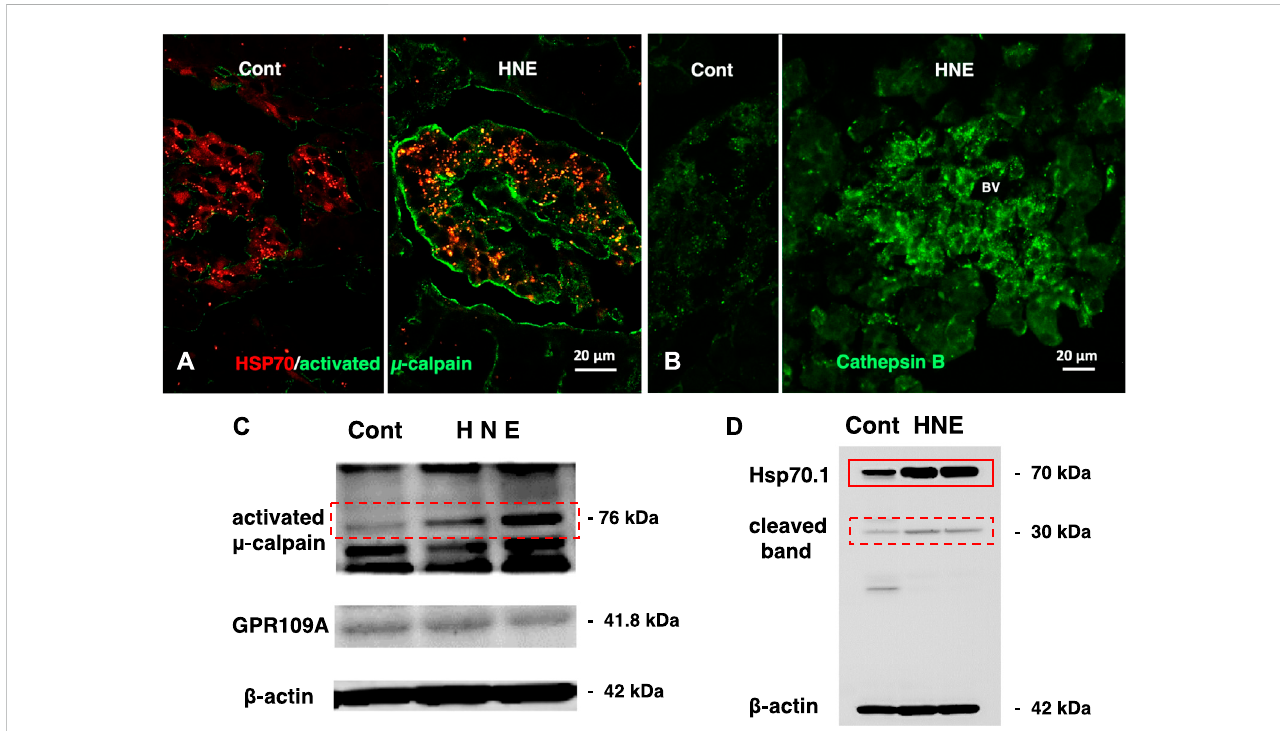
FIGURE 5 Calpainactivation,Hsp70.1cleavage,andcathepsinBleakageinthemonkeysaftertheconsecutivehydroxynonenal(HNE)injections.Panel (A) Activated μ -calpain immunoreactivity (green) is negligible before HNE injections (Cont), whereas μ -calpain activation occurred after HNE injections (HNE), being consistent with the Western blotting data (Panel (C) , activated μ -calpain). After HNE injections, activated μ -calpain immunoreactivity (green) is colocalized with Hsp70.1 immunoreactivity (red), showing a merged color of yellow (HNE, yellow). Panel (B) Cathepsin B is stained as tiny granules in the control Langerhans islet (Cont), whereas stained as coarse granules with the perigranular immunoreactivity after HNE injections (HNE), which indicates lysosomal membrane rupture/permeabilization. Panel (C) By Western blotting, μ -calpain is activated after HNE injections (dot rectangle), compared to the control (Cont). As this anti- μ -calpain antibody recognizes only activated form of μ -calpain, but not inactivated form, positive bands indicate activation of μ -calpain. Panel (D) In response to HNE injections, not only Hsp70.1 main bands (rectangle) but also cleaved Hsp70.1 bands of 30 kDa (dot rectangle) are increased, compared to the control. Reprinted with permission from Boontem and Yamashima